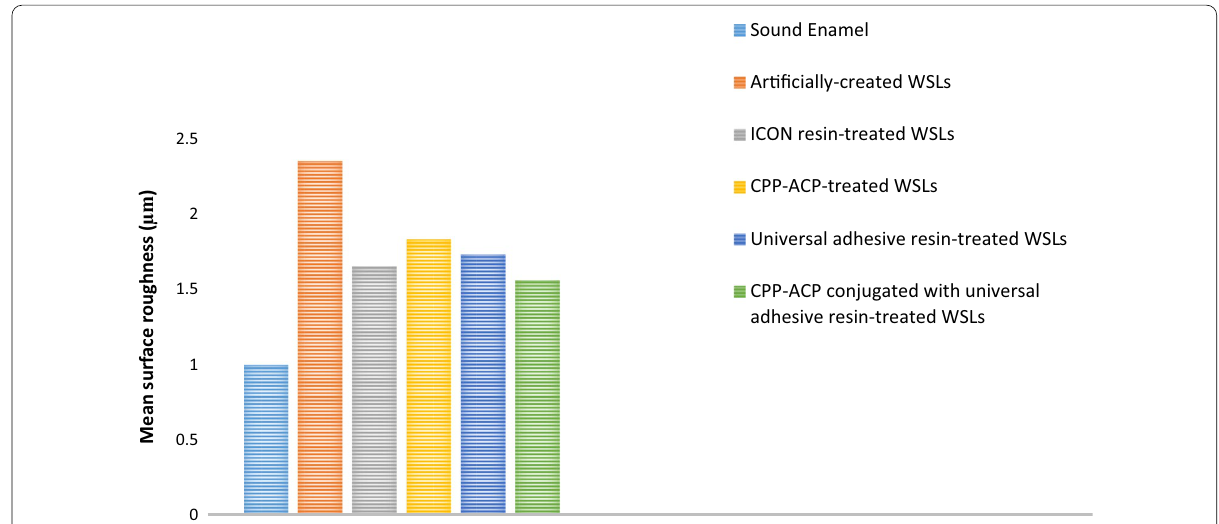
Fig. 4 Surface roughness results of the investigated